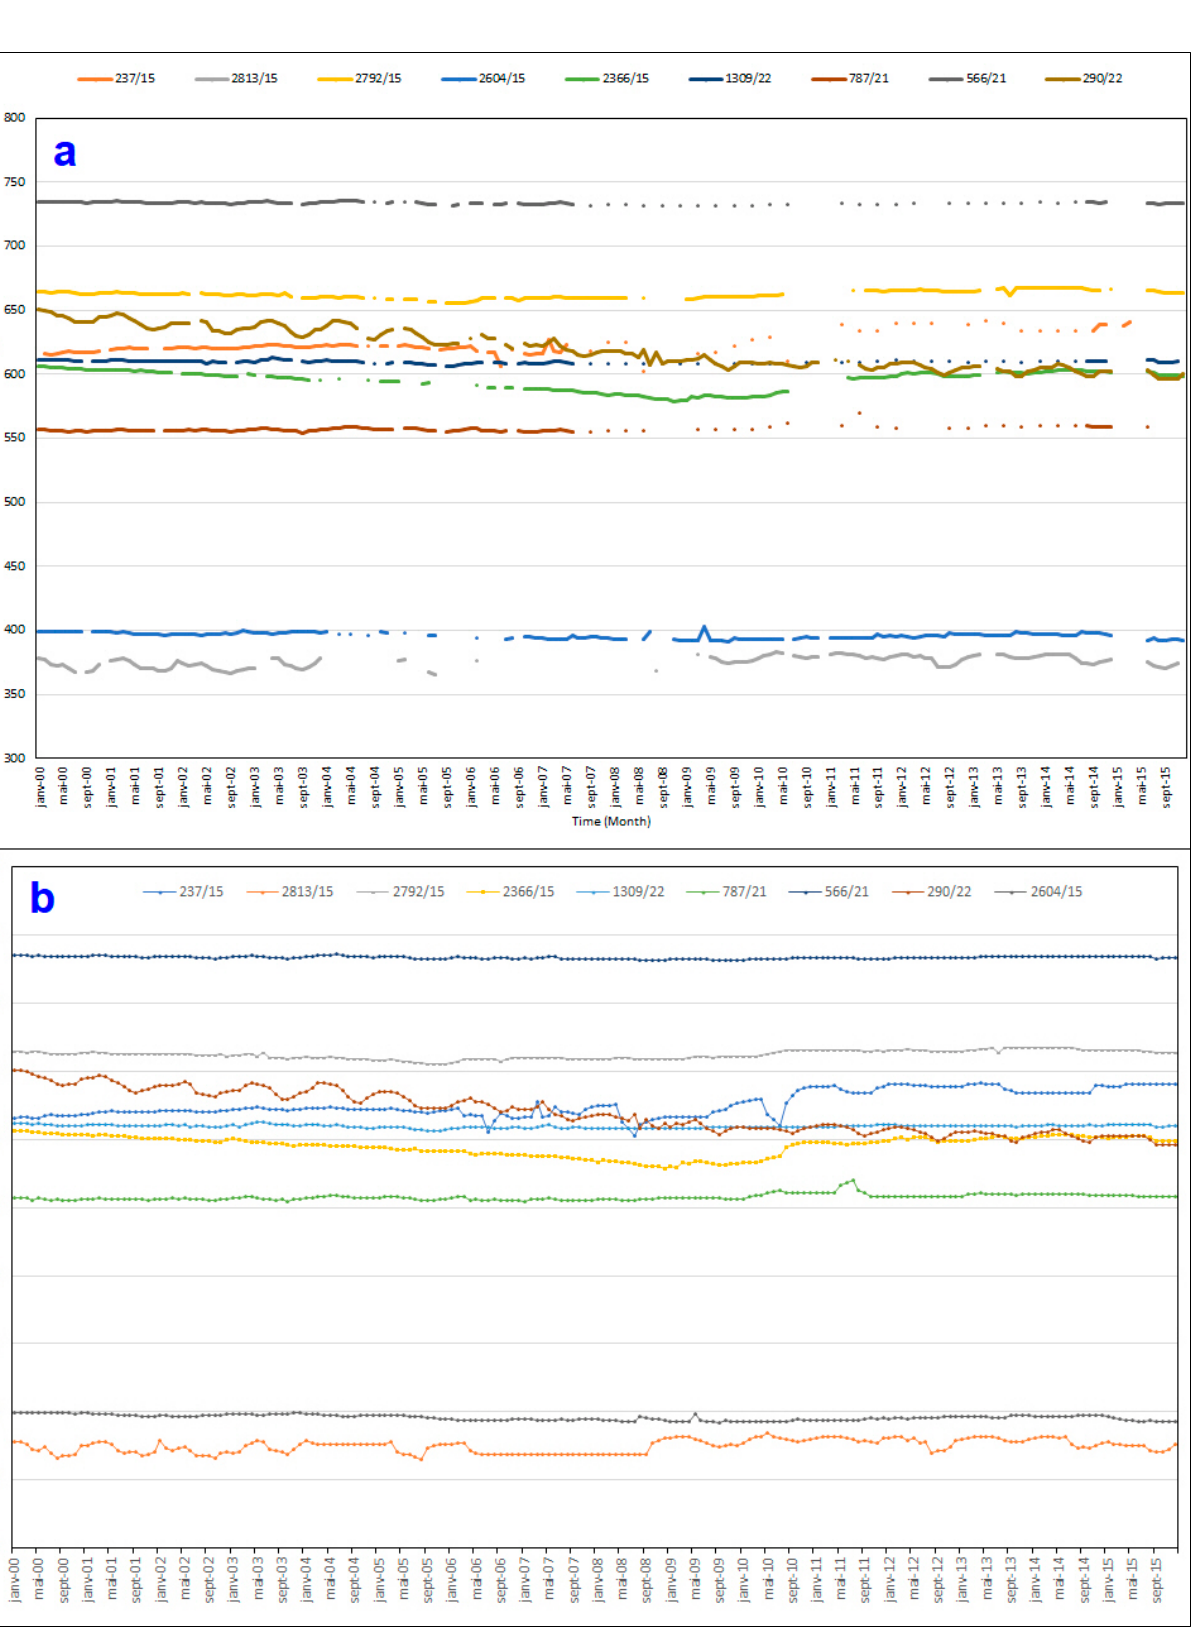
Figure 10. ( a ) Original groundwater level time series containing missing values. ( b ) The reconstructed groundwater levels and gap values filled using ARIMA model for nine selected piezometers .